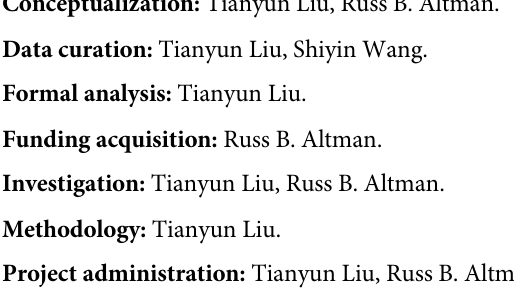
a disease. Fig G: The Number of genes associated with diseases is plotted against the P-value estimating the correlation between the predicted NAAS and the literature sampling frequency of cytokines. Fig H: The NAAS between aneurysm and each of the 79 cytokines are plot against the literature sampling frequency in aneurysm. Fig I: Graph plots showing interactions between pathogenesis genes and inflammatory responses. Fig J: Hierarchical structure showing information flow from pathogenesis genes to inflammatory responses. Table A: Statistics of selected sets from STRING and three classes of functional modules. Table B: Gene signatures identified for the six groups of cytokines. Table C: The predicted cytokine profiles correlate with the known literature sampling frequency in ImmuneXpresso for the 171 well-studied dis- eases. Table D: The 171 diseases classified into three clusters based on their cytokine profiles. Table E: Disease-associated genes in the well-connected modules formed by pathogenesis genes, receptors, and essential cytokines identified by spectrum partition in the context of five immune disorders. Table F: Frequency (#) in the five